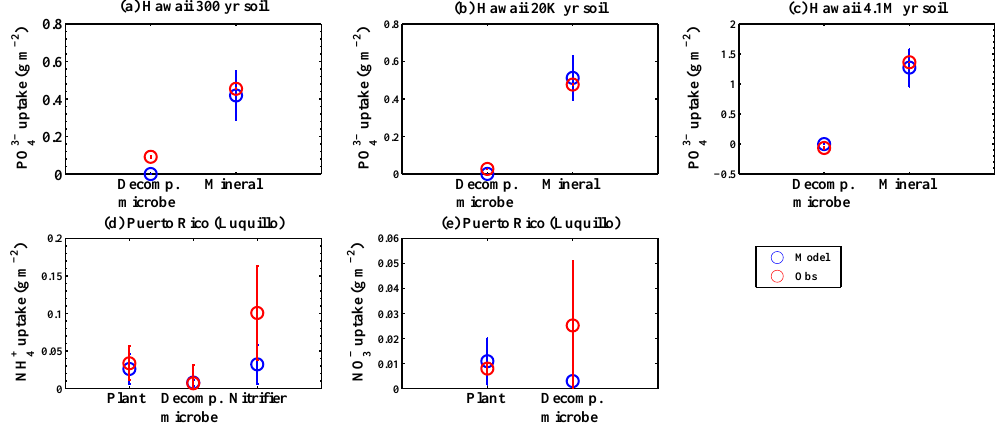
Figure 5. Model perturbation experiments compared with nitrogen and phosphorus fertilization field experimental data. The blue dots show the difference between control and perturbed simulations, which mean how much newly added nutrient each consumer takes up. The red circles are recovered isotopically labeled nutrient within each consumer. Since plants phosphorus uptake was not measured at Hawaii sites, we did not include the plants in the perturbation